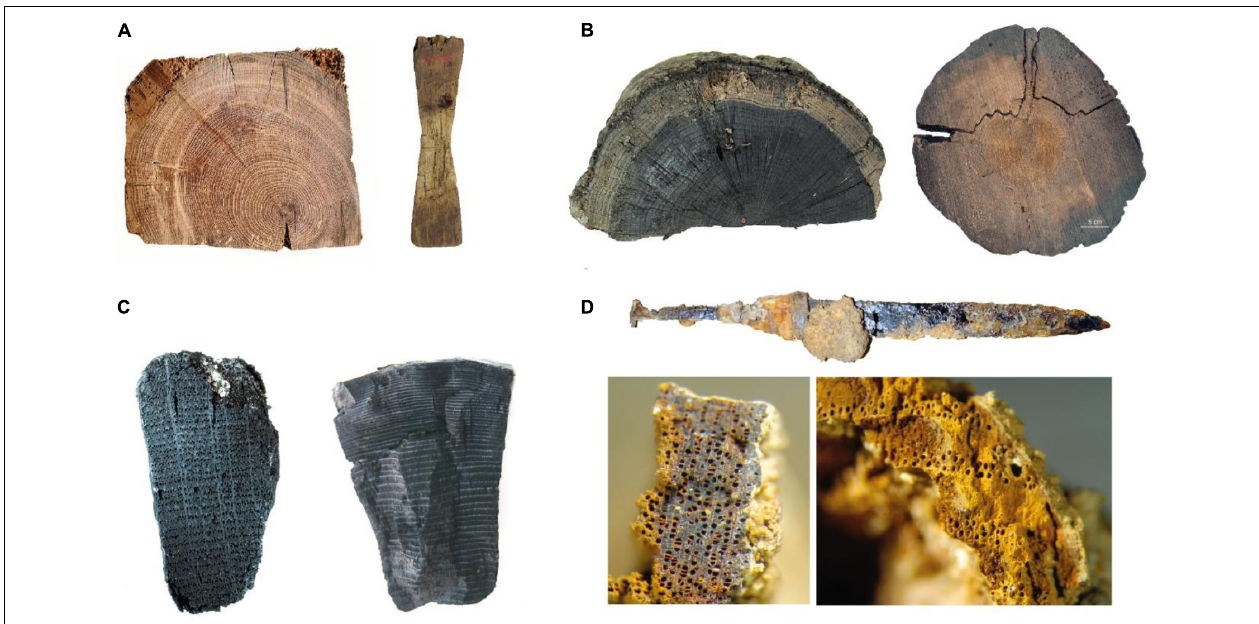
FIGURE 3 | Different types of wood preservation. (A) Dry preserved wood from scaffolding timber from the cathedral Notre-Dame de Reims, France (1211 CE, Tegel and Brun, 2008) and the “pagan wall” on Mont Sainte-Odile, Ottrott, France (7th century CE, Tegel and Muigg, 2015). (B) Wood preserved under wet conditions from a late bronze age well made of oak in Erstein, France (1208 BCE) and from a preboreal pine from gravel quarry at Pont-sur-Seine, France ( 14 C 11000 ± 60 BP). (C) Charcoal from oak (Cuperly, France, 133 BCE) and silver fir (Schauinsland, Germany, 1545). (D) Wood (alder ( Alnus sp.; left ) and ash ( Fraxinus excelsior ; right ) preserved through mineralization processes on early medieval weapons, found as grave goods in burials (Tegel et al.,